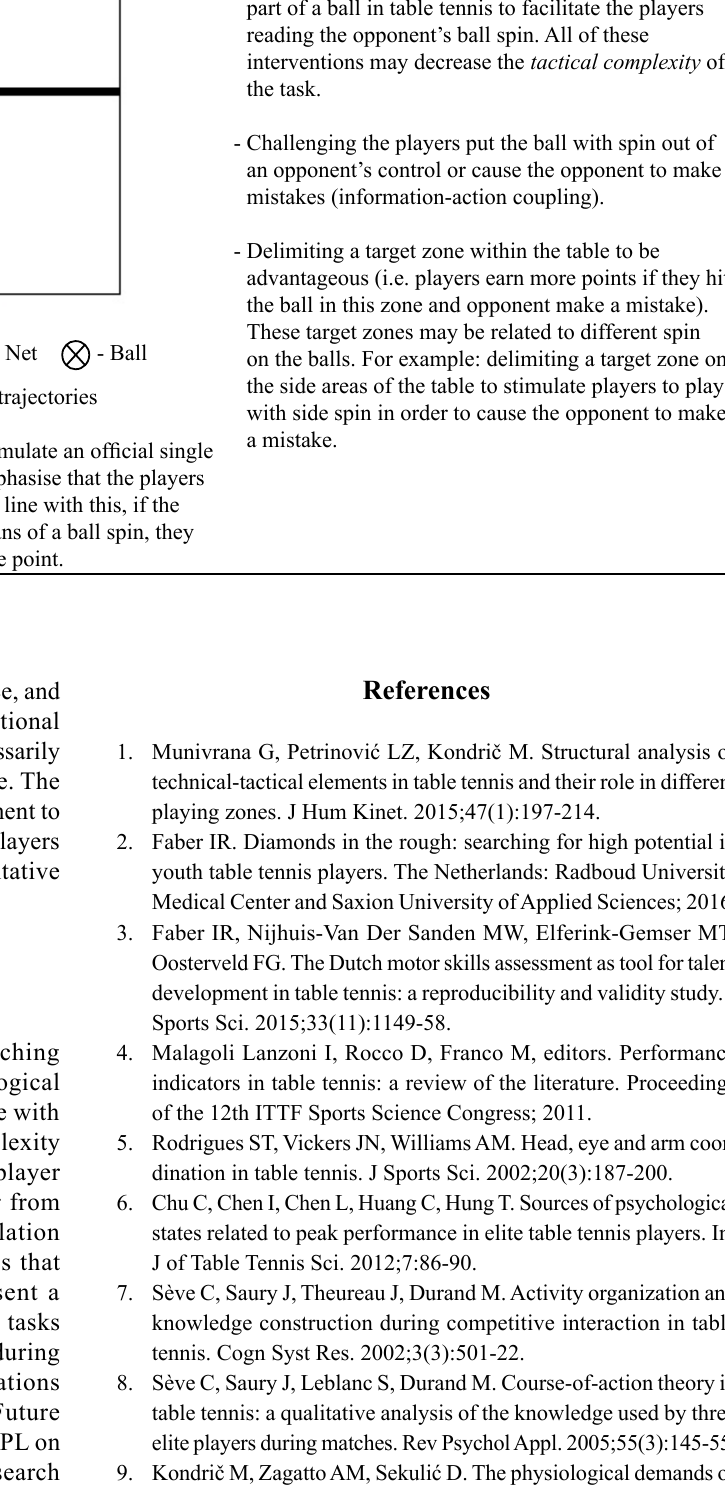
table tennis: a qualitative analysis of the knowledge used by three elite players during matches. Rev Psychol Appl. 2005;55(3):145-55. table tennis: a review. J Sports Sci Med.